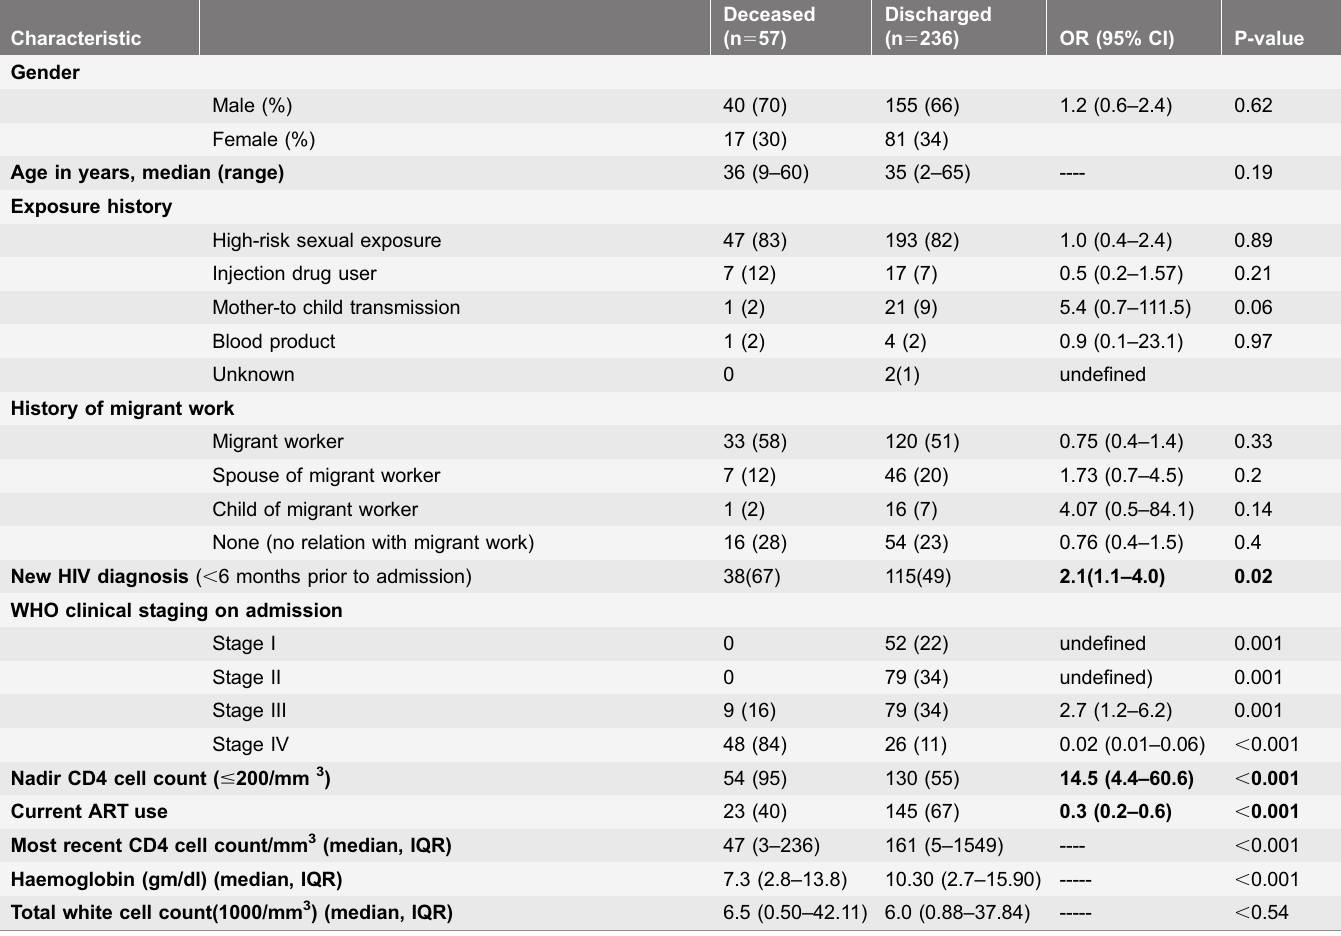
Table 1. Baseline characteristics of the HIV-infected patients stratified by outcome.